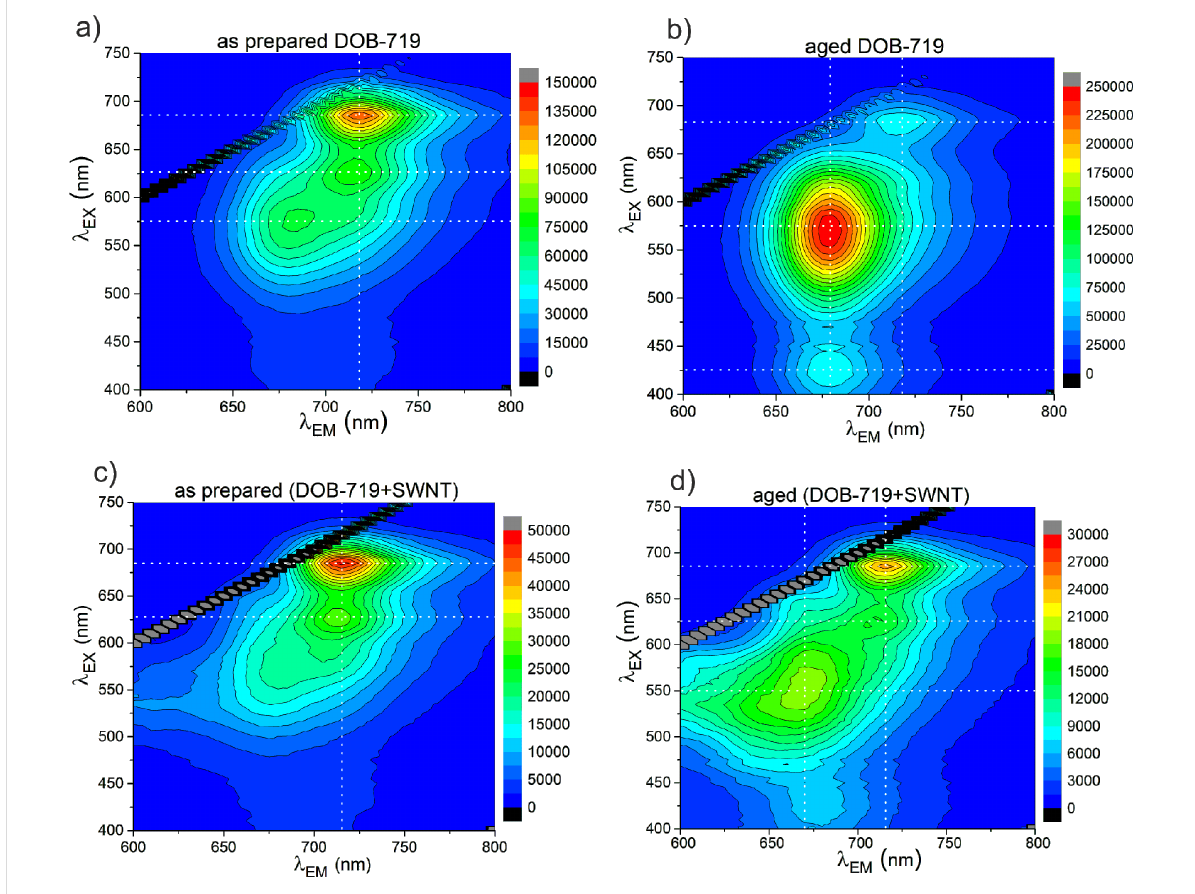
Figure 5: PLE maps of aqueous solutions for (a) the as-prepared and (b) aged neat DOB-719 as well as (c) the as-prepared and (d) aged mixtures of DOB-719 with SWNTs in water. High PL intensities are coded in red colour, whereas low intensities are coded in blue colour. The concentration of DOB-719 is 0.001